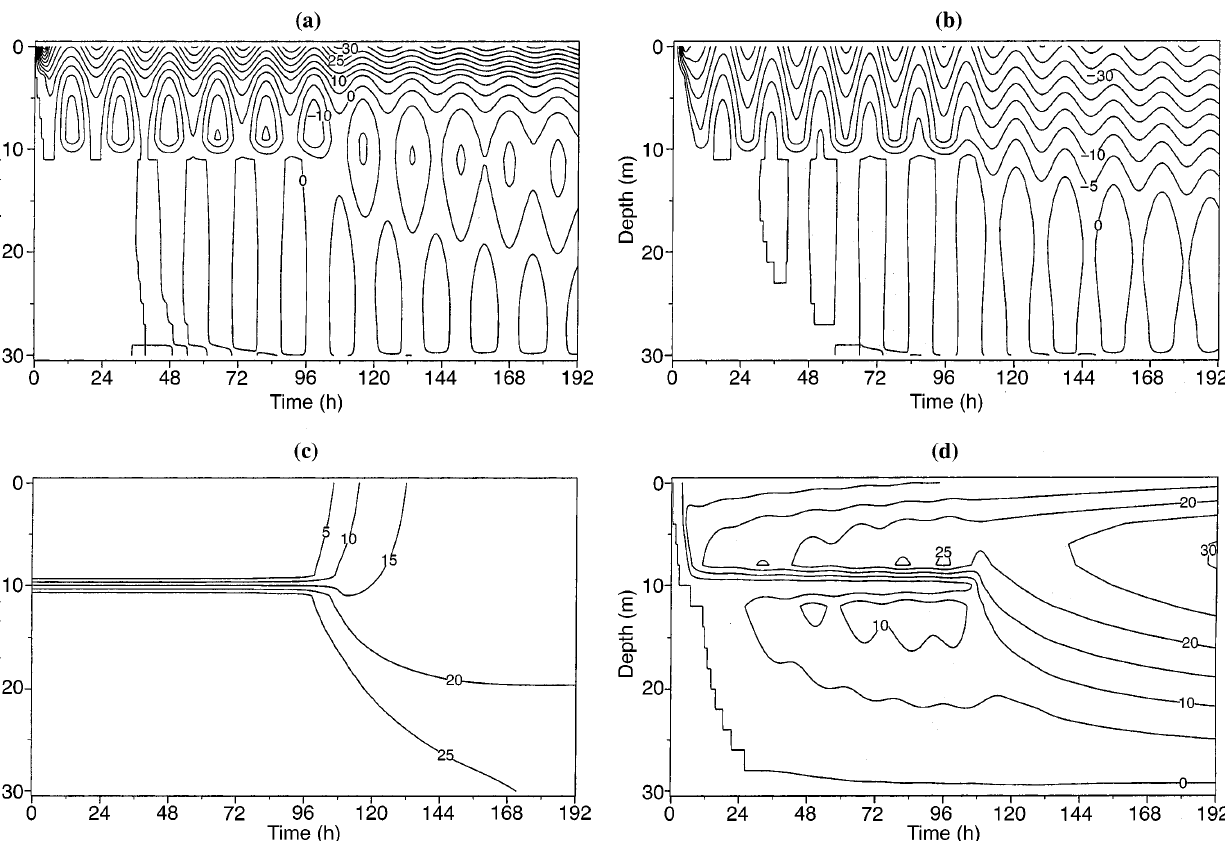
Fig. 1a–d. Solution of the direct simulation used to construct the observations. a Velocity u (cid:133) cm (cid:1) s (cid:255) 1 (cid:134) , b velocity v (cid:133) cm (cid:1) s (cid:255) 1 (cid:134) , c salinity (psu), d turbulent viscosity (cid:133) cm 2 (cid:1) s (cid:255) 1 (cid:134) . The contour intervals are 5 units for each variable